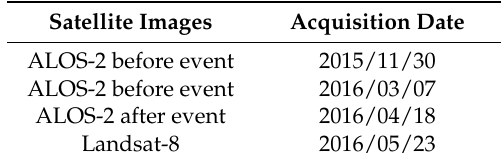
Table 1. Satellite images used in this study.